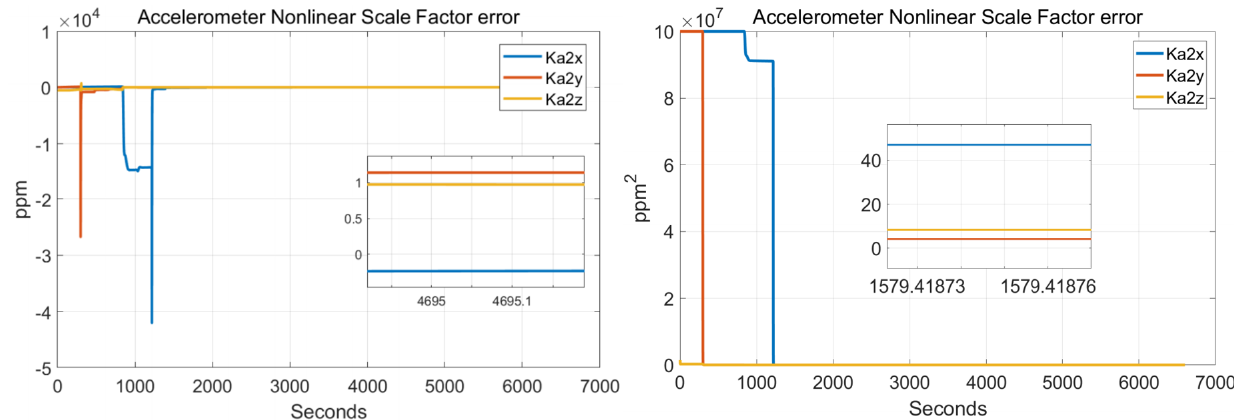
Figure 11. Accelerometer nonlinear scale factor errors.